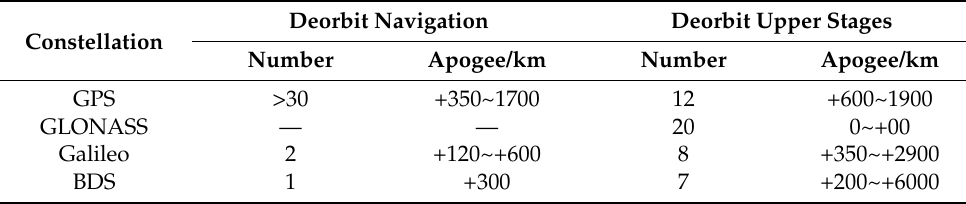
Table 3. Deorbit statuses of the retired navigation satellites and the spent upper stages [22].